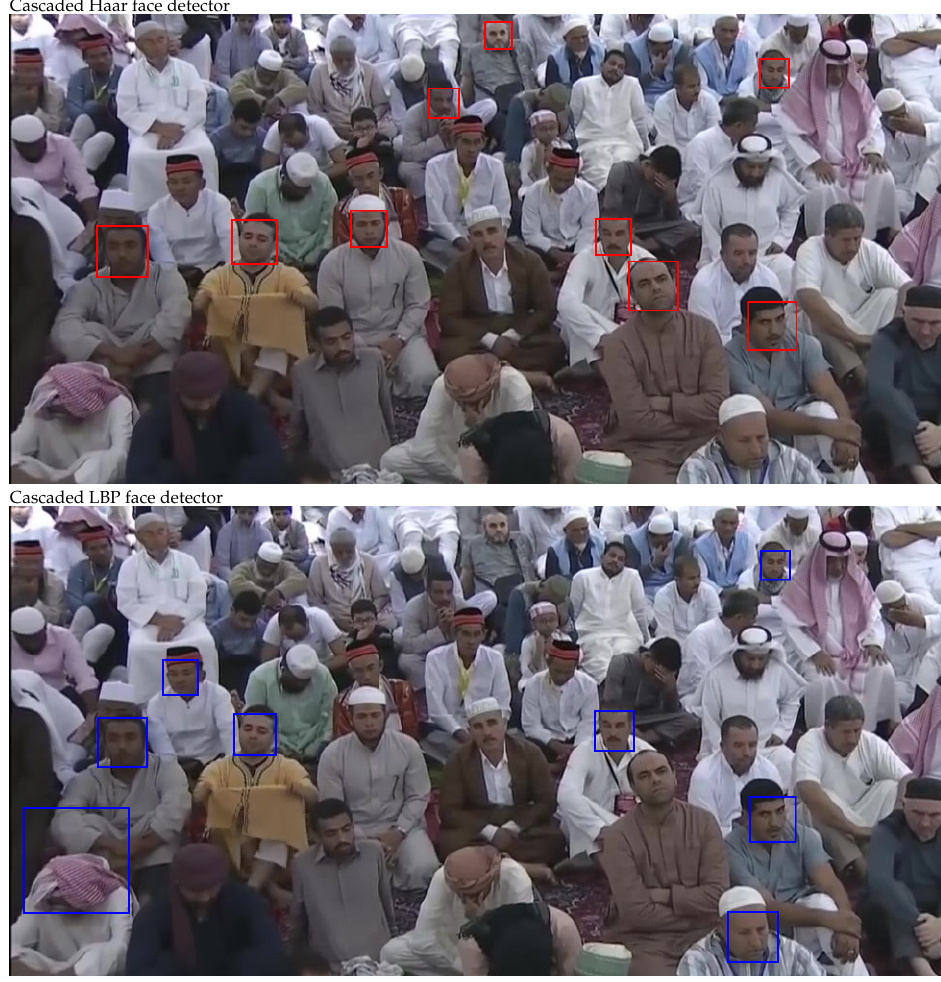
Figure 4. Face detection by three cascaded face detectors.